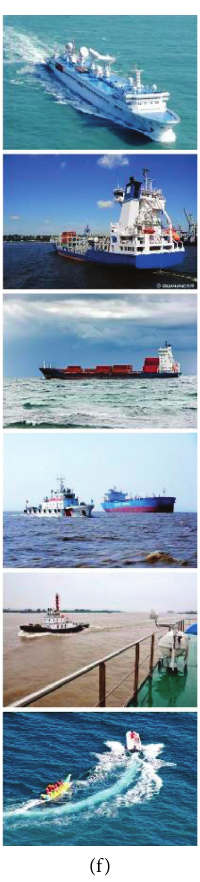
Figure 6: Visual comparisons of synthetic experiments on six images with transmittance value � 0.1 and atmospheric light value � 0.7. From left to right: (a) synthetic haze image and dehazed images generated by (b) DCP [23], (c) RIVD [30], (d) MSCNN [12], (e) ours, and (f) original clear images,